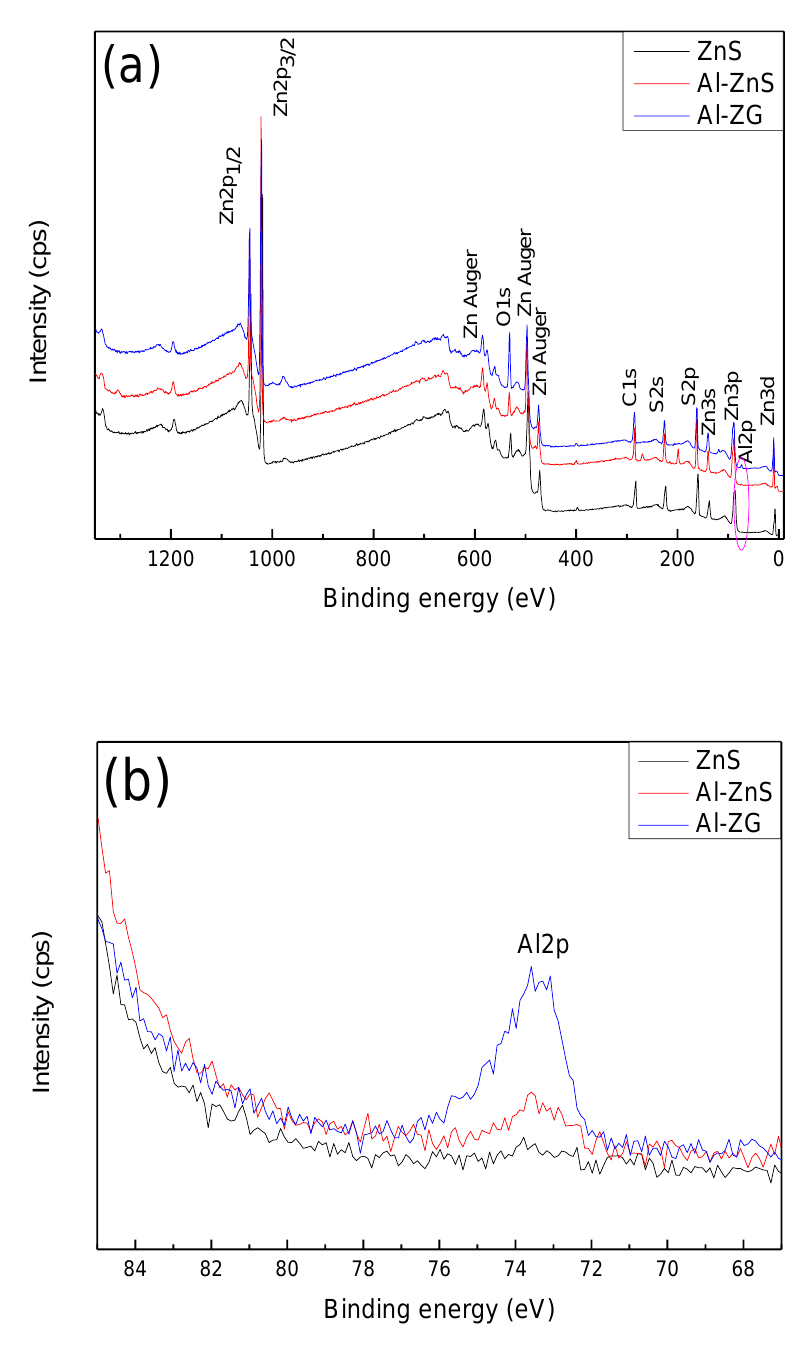
Figure 2. ( a ) Survey and ( b ) Al 2p spectra of pure ZnS, Al-ZnS and Al-ZG. Table 1. Atomic% of elements from the XPS data for the pure ZnS, Al-ZnS and Al-ZG.